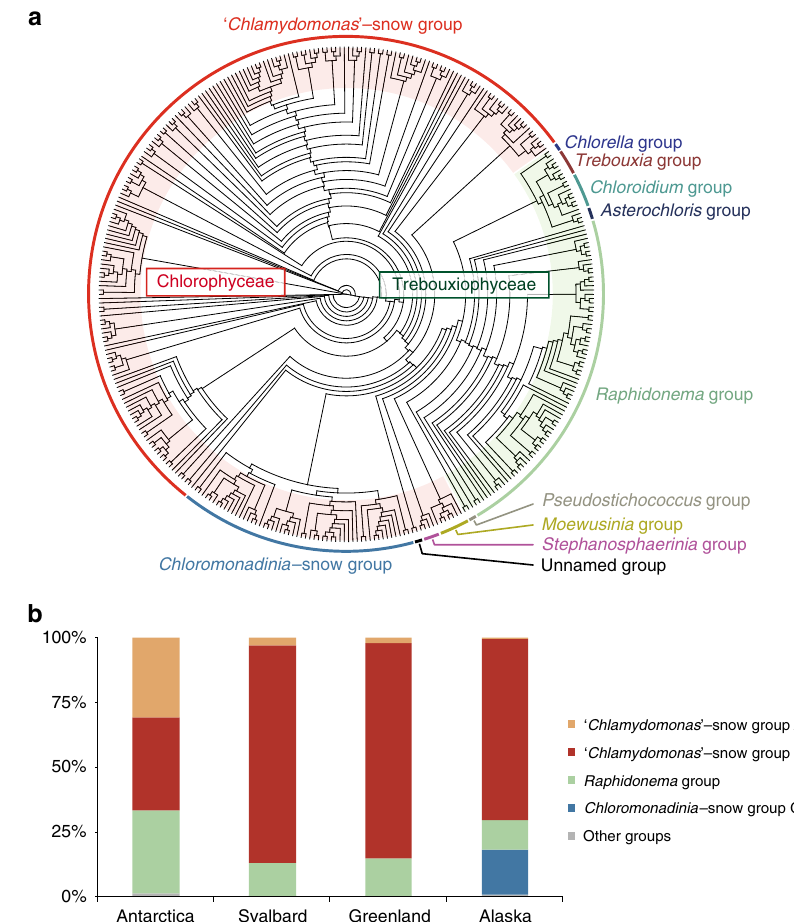
Fig. 2 Classi fi cation of red-snow algae based on ITS2 sequence. a Phylogenetic relationship of 348 OTUs (98% OTU) based on ITS2 region sequences. A maximum likelihood tree was constructed with 1000 bootstrap replications using RAxML version 8.2.10 with the GTR + I + Γ model. In 98% OTUs, identical sequences were reduced to a single OTU. Taxonomic groups that were de fi ned by the secondary structure of ITS2 are labelled and distinguished based on colour. For detailed information, see Supplementary Figure 1. b Algal taxonomic composition of the Illumina reads in red-snow samples based on ITS2 sequences. The bar chart presents data for the average community composition of each region based on the four major ITS2 groups and low-abundance groups (grouped as “ Other groups ”